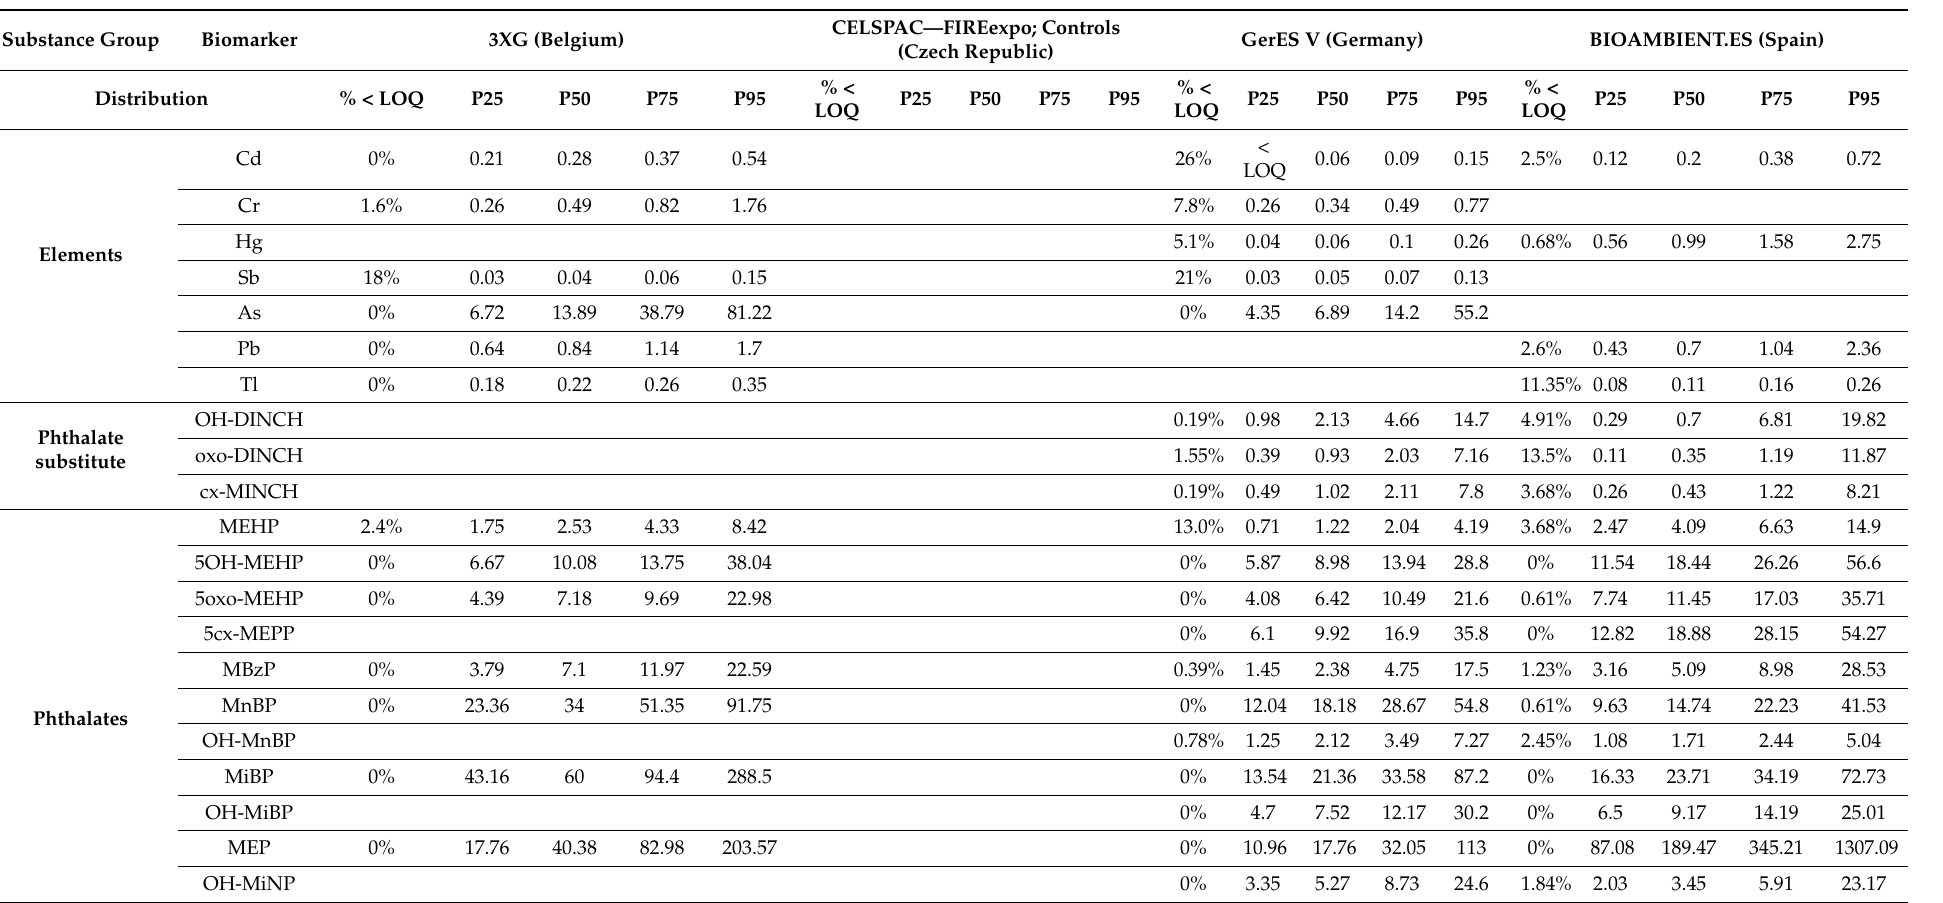
Table 1. Descriptive statistics for biomarkers included in the network analysis measured in more than one study. PFAS were measured in blood(in µ g/L), all others in urine (in µ g/g